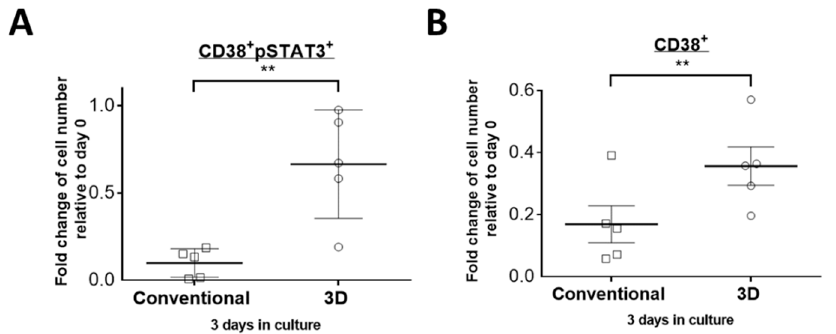
Figure 3. STAT3 activity is higher in PM cells cultured in 3D. Fold change of viable ( A ) CD38 + pSTAT3+ and ( B ) CD38+ cell number from 5 MM patients in conventional or 3D culture on day 3 relative to day 0. The mean value was indicated with error bars representing standard error. ** p < 0.001, paired Student’s t -test.